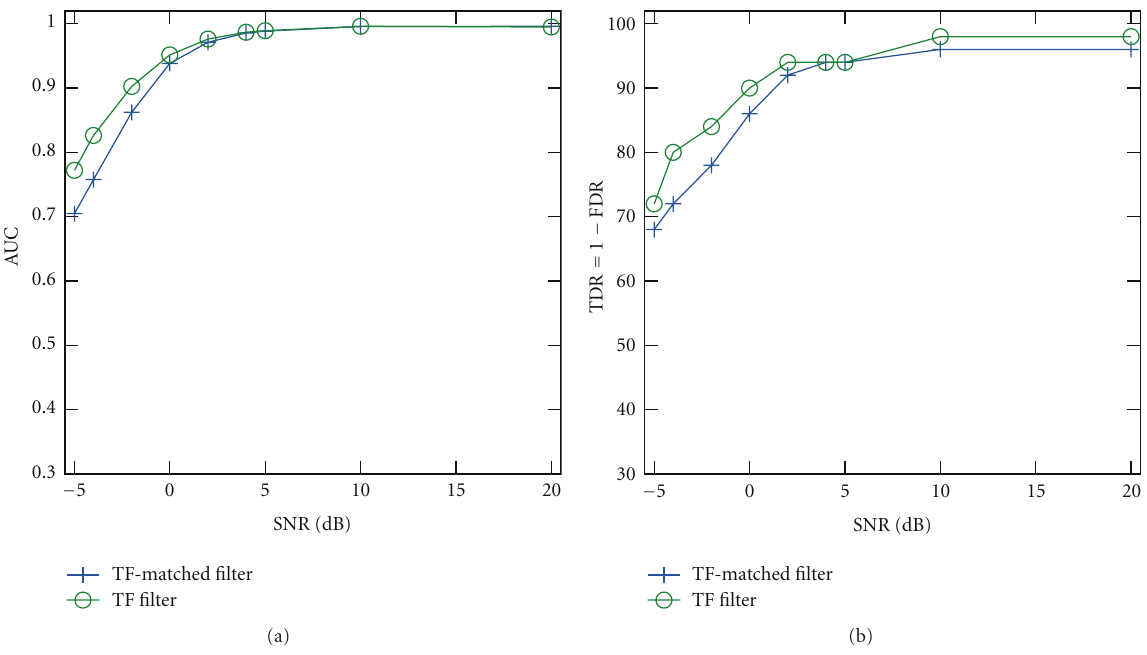
Figure 13: Detection results for white Gaussian noise with high-energy harmonics.